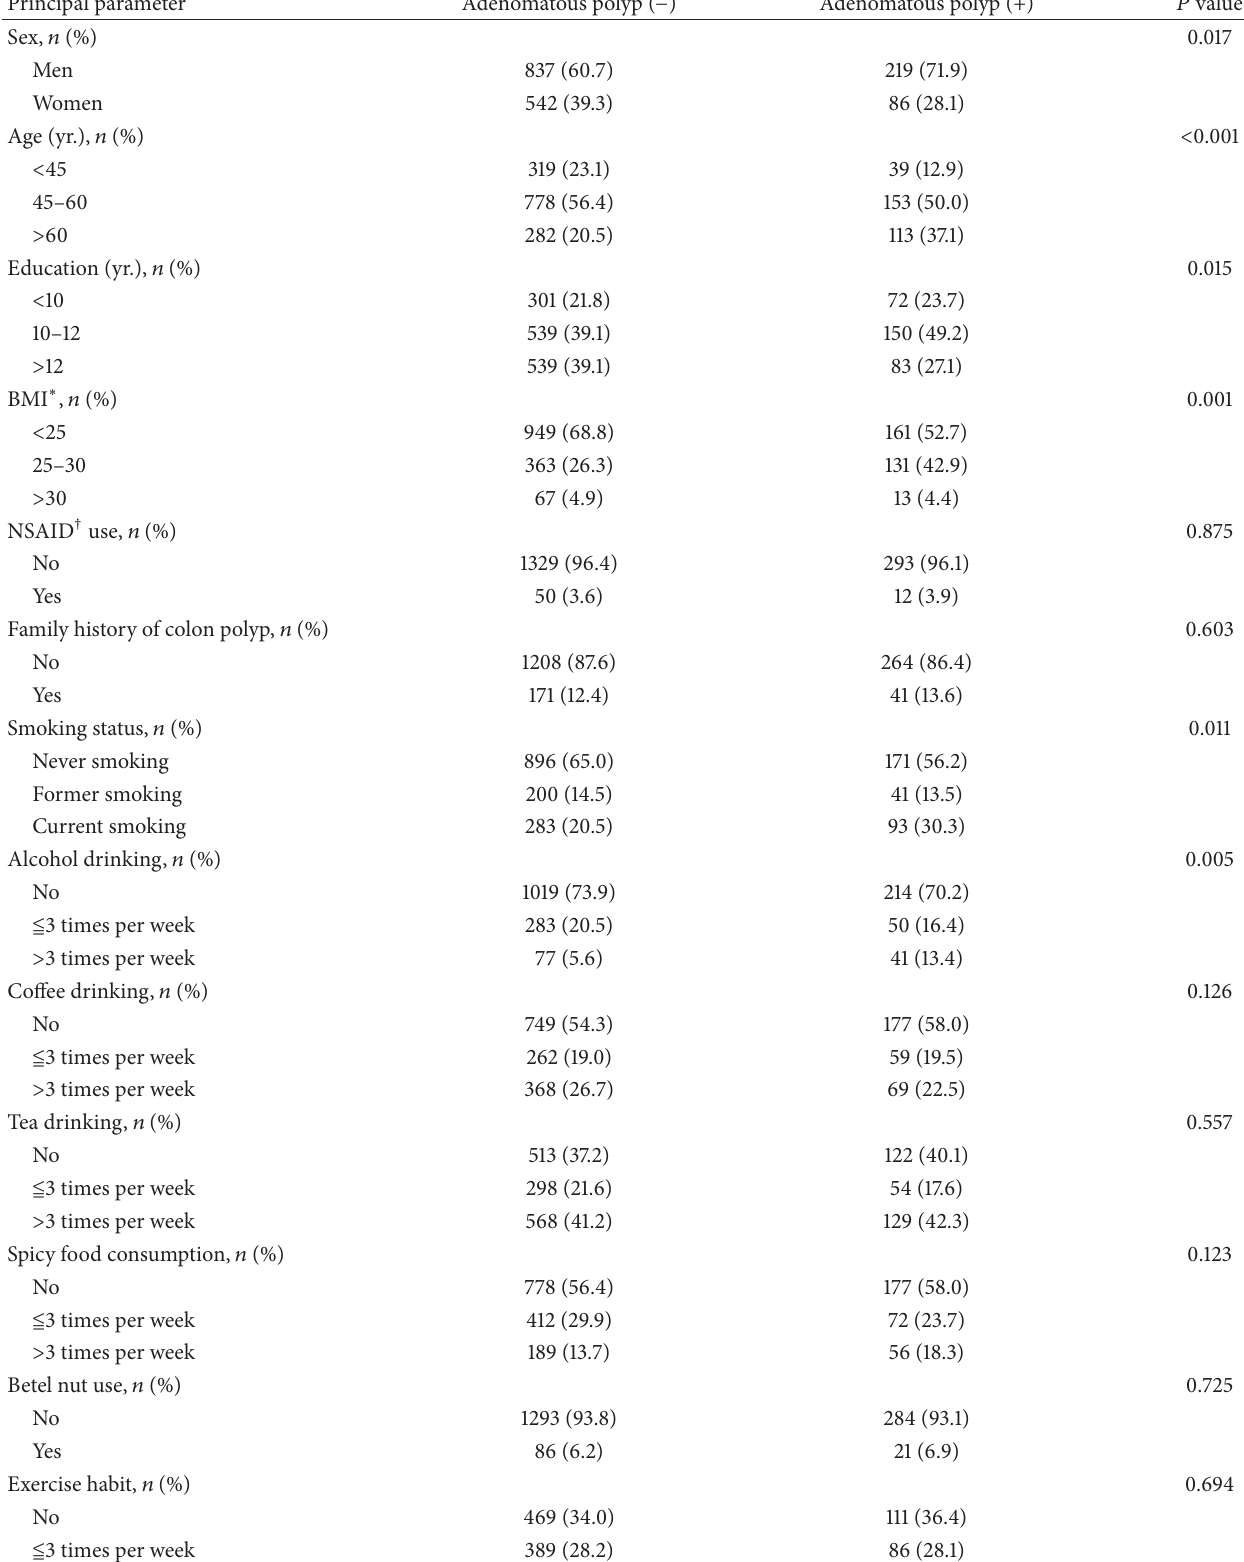
Table 4: Univariate analysis of the risk factors for the development of colorectal adenomatous